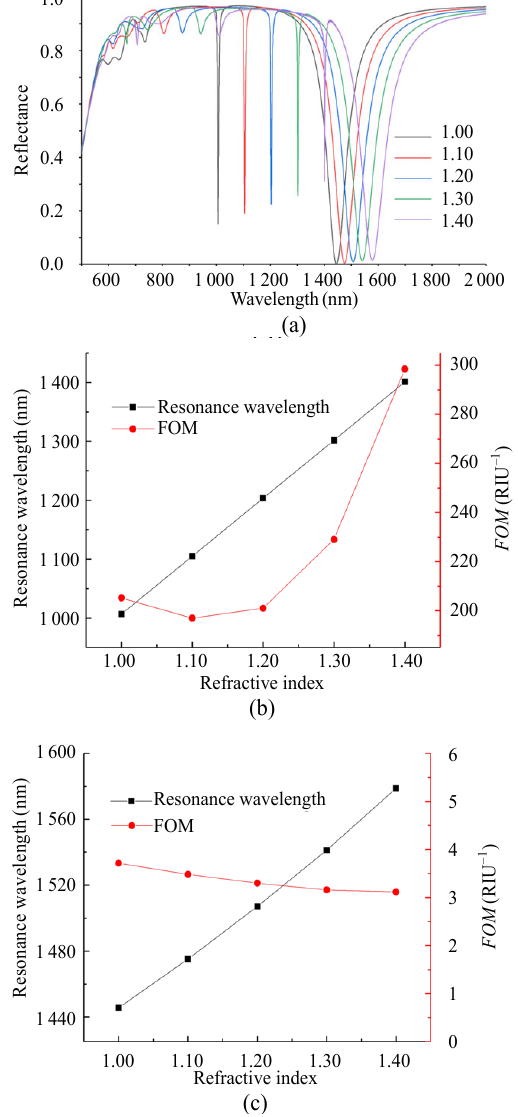
Fig. 9 Sensing performance of the 2D grating composite structure: (a) reflective spectra of the composite structure when the analyte refractive index ranges from 1.0 to 1.4 in steps of 0.1. The relationship of the resonance wavelength and FOM with the analyte refractive index in (b) Mode 1 and (c) Mode 2.